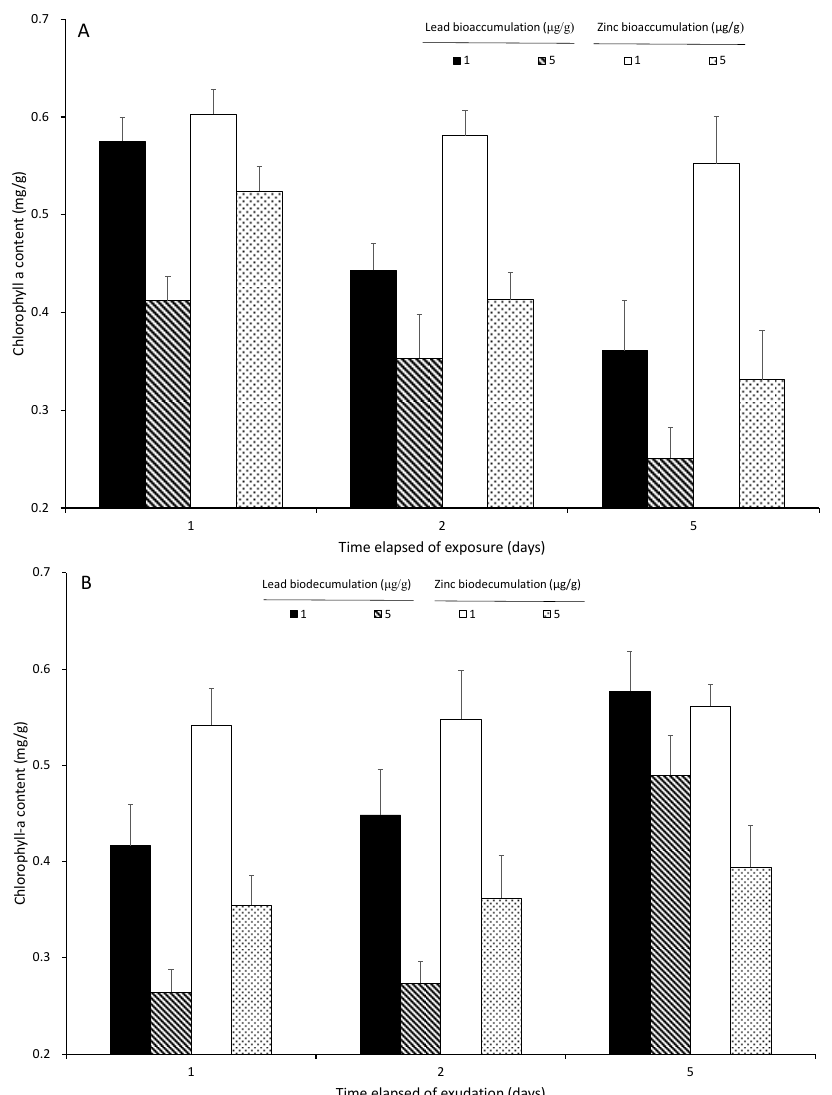
Figure 4. Chlorophyll-a contents (mg/g) of S. suiae exposed to various lead (1 and 5 Pb 2+ mg/L) and zinc (1 and 5 Zn 2+ mg/L) concentrations for 1, 2, and 5 days ( A ). Chlorophyll-a contents (mg/g) of S. suiae after 1, 2, and 5 days exudation following exposure to various lead (1 and 5 Pb 2+ mg/L) and zinc (1 and 5 Zn 2+ mg/L) concentrations for 5 days ( B ). ± 0.470 mg/g. The phycobiliprotein contents were 2.489 ± 0.093, 1.443 ± 0.050, and 1.182 ±